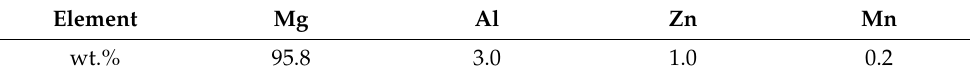
Table 1. Chemical composition of AZ31B magnesium alloy (X-ray fluorescence analysis). Element Mg